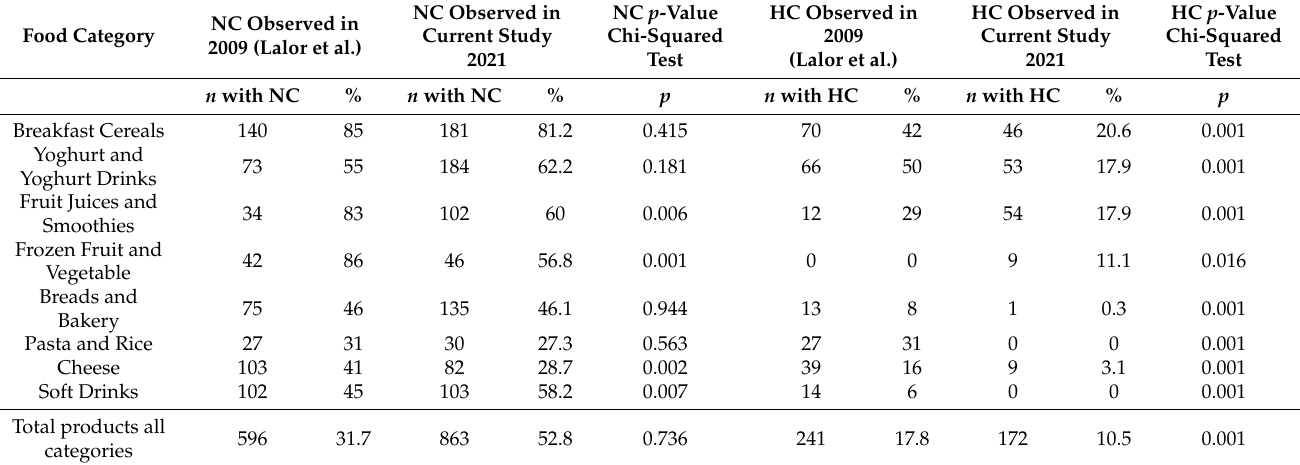
Table 7. Evolution of the proportion of claims by food category between 2009 and